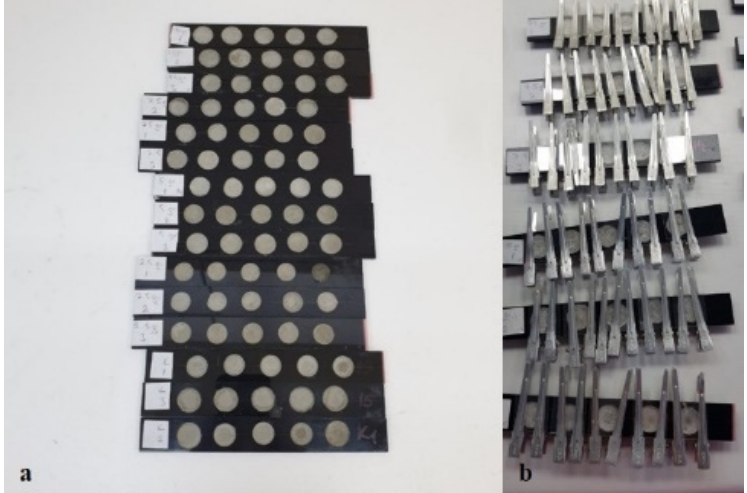
Figure 1. Plexiglass cells used in biological tests before ( a ) after ( b ) application. Dust and wettable powder formulations of local diatomaceous earth (Detech ® WP 95 and Detech ® Dust) were applied to the mite cells on the concrete surface in five different concentrations (1, 2.5, 5, 7.5, 10 g/m 2 ). After the DE treatments, dead and alive individuals were counted at 11 different time intervals (1, 3, 6, 9, 12, 15, 18, 21, 24, 27, and 30 h). The experiments were carried out at a temperature of 25 ± 1 ◦ C, 75 ± 5% RH, and under dark laboratory